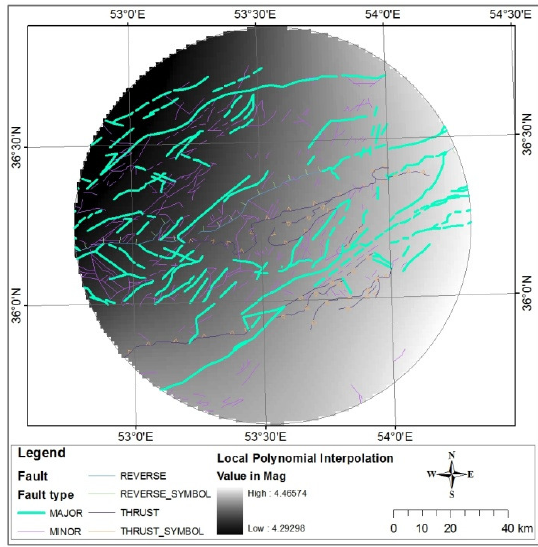
Figure 2: the map of LST from Landsat thermal bands The interpolated map by OK indicates higher seismic activities on the southern slopes of Alborz Mountain Range. In the southeast of the buffer of the area the highest values of earthquake magnitudes can be observed (Figure 3). According to this illustration the southern and southeastern portions of the study area have more seismic activity. The only exception about